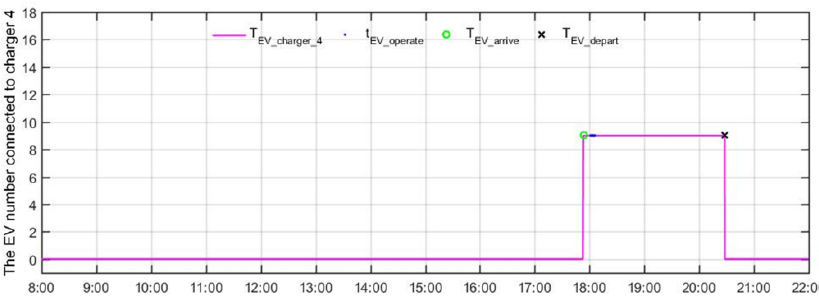
Figure 18. The operating time of EVs connected to charger 4 under ICDA.